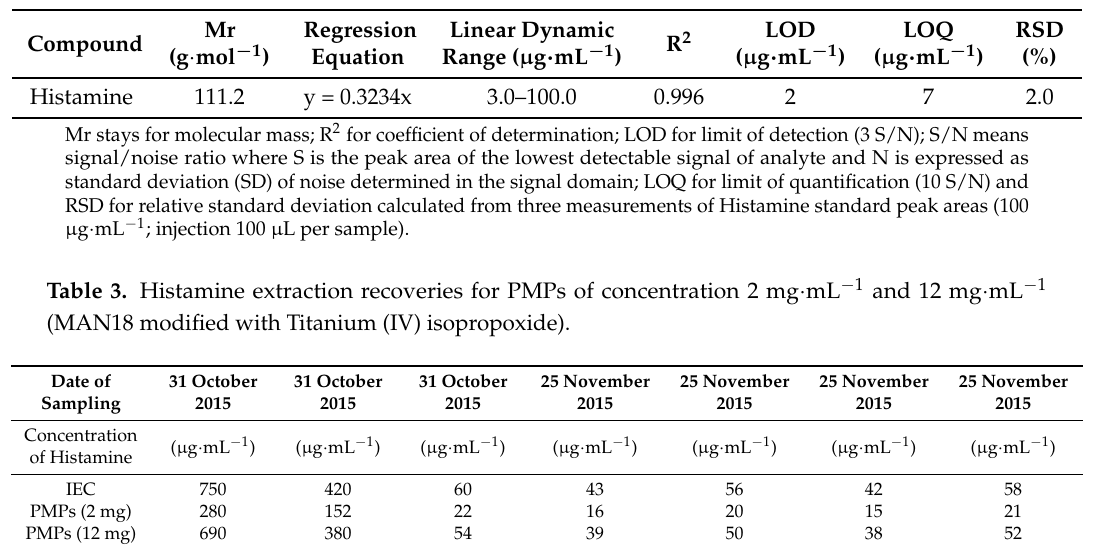
Figure 4. ( A ) Scheme of isolation of biogenic amines from silage sample of PMPs; ( B ) Typical chromatograms overlay: red—Samples of silage bound on PMPs and green—Sample of silage before isolation on PMPs; ( C ) Saturation curve measured under the optimal conditions within tested concentration range 2, 4, 8, 12, and 16 mg · mL − 1 of PMPs. Table 2. Analytical parameters of analysis of Histamine.